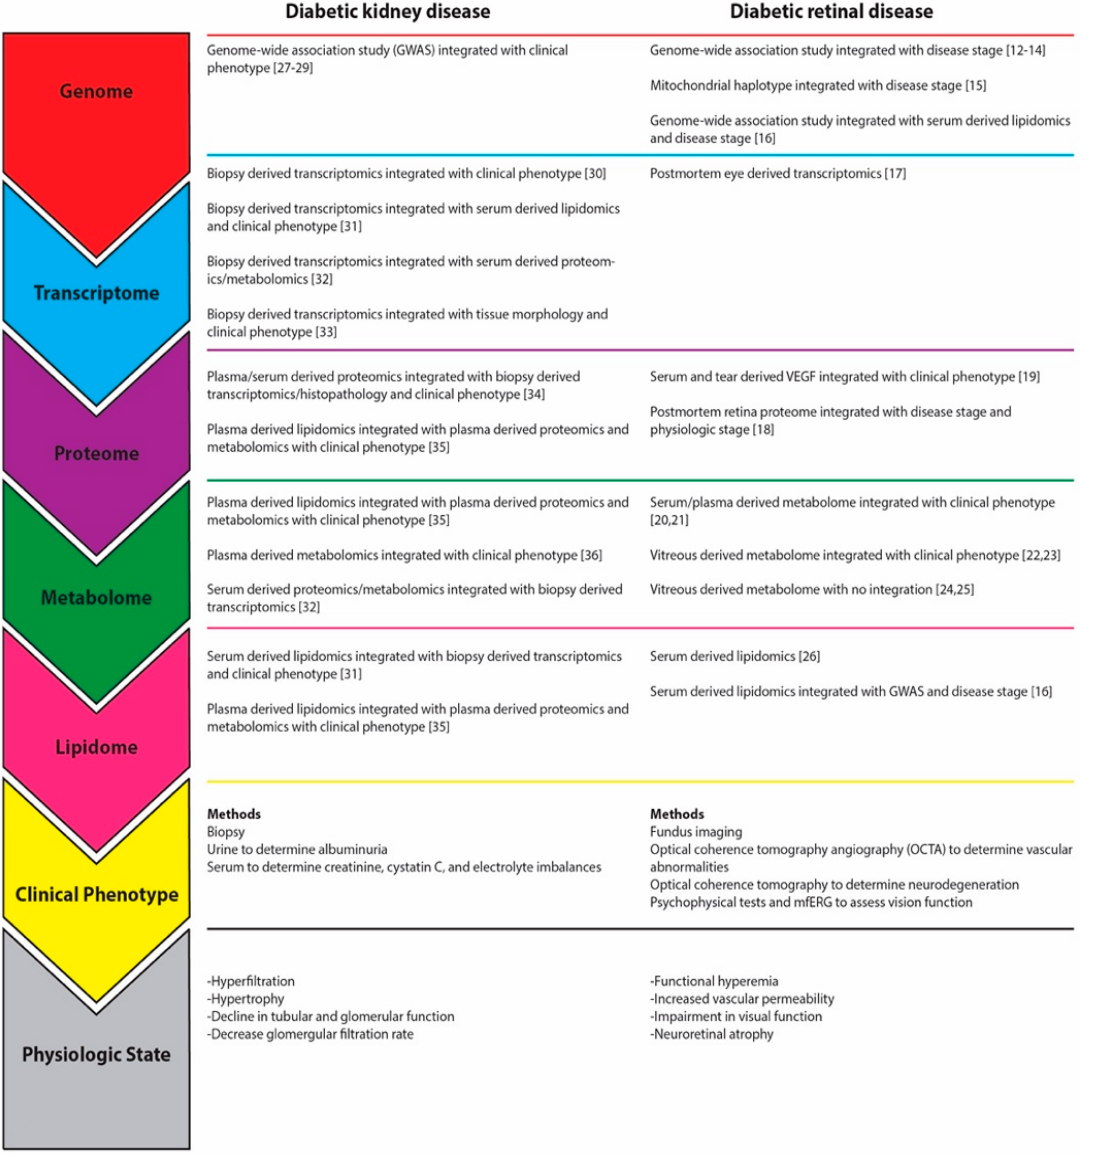
Figure 1. Systems Biology of diabetic retinal disease (DRD) and diabetic kidney disease (DKD): Integration of Multi-Scalar Data. Individual studies examining either diabetic kidney disease ( left column) or diabetic retinal disease (right column) are listed based on the different types of data labeled vertically on the left, demonstrating downward multi-scalar integration of data [12–36]. Additionally, the methods and physiologic manifestations of the disease are listed as clinical phenotype and physiologic state,